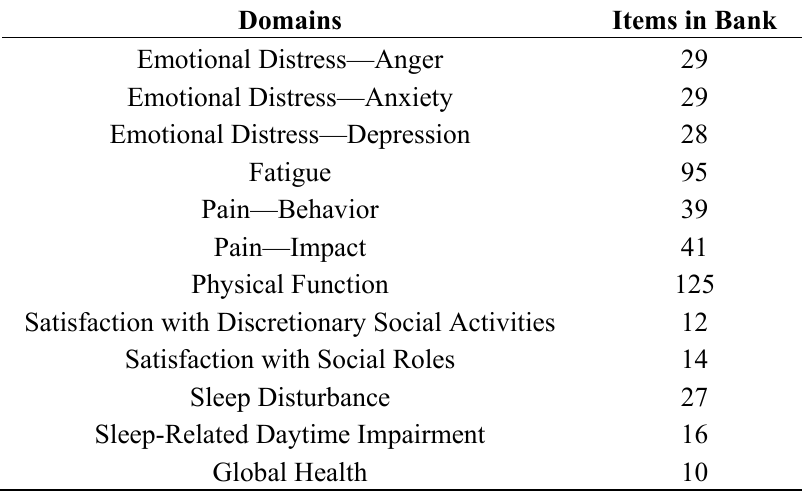
Figure 1. PROMIS Domain/Topic Framework. Table 1. PROMIS Core Health